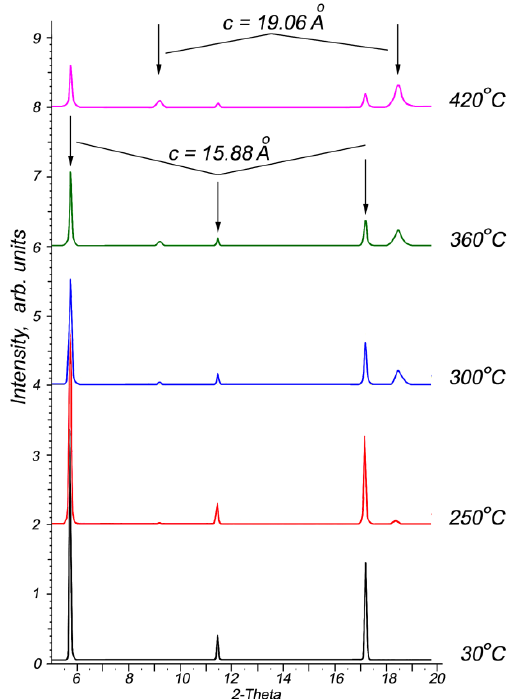
Figure 6. High-temperature X-ray diffraction patterns of In 1.2 Ga 0.8 S 3 ·0.5(NH 2 -C 5 H 4 N) crystals in the temperature range of 30 – 420 °C.